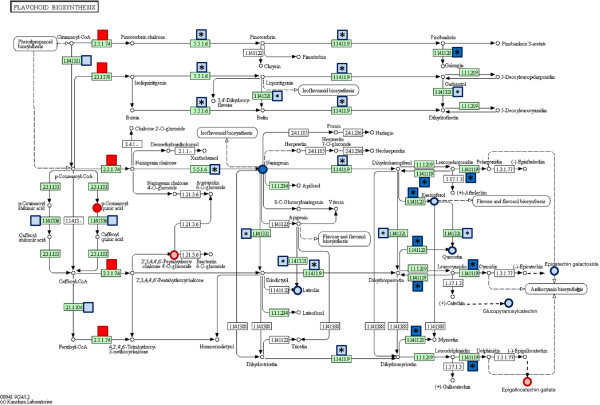
Combined mapping of transcriptomic and metabolomics data onto the KEGG reference pathway “flavonoid biosynthesis”. Log2 fold changes of RPKM ratios according to Additional file 6 and of mass intensities according to Additional file 5 were mapped on the KEGG reference pathway. Big asterisk in the box, specific mapping of the transcript to flavonoid biosynthesis; small asterisk in the box, mapping of the transcripts to the pathways “flavonoid biosynthesis” and “flavone and flavonol biosynthesis”; no asterisk in the box, unspecific mapping of the transcript to several pathways. For further information see legend of Figure 8.